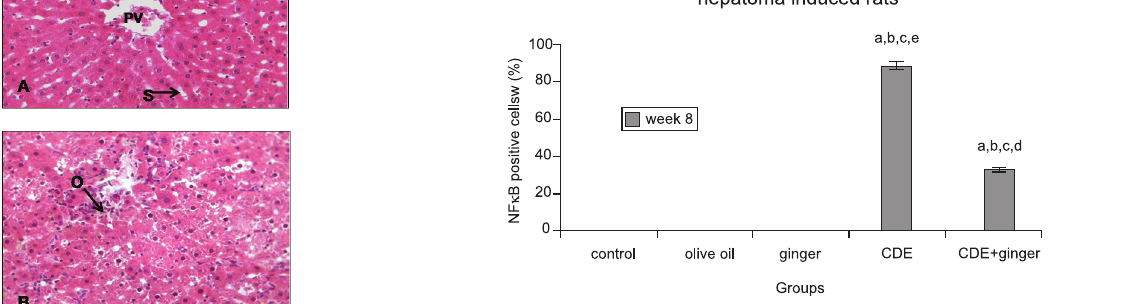
Figure 3 - The effect of ginger extract on NFkB expression in liver cancer- induced rats. The graph shows the positive expression of NFkB based on the different diets given. A = p ≤ 0.05 compared with eight-week control group; b = p ≤ 0.05 compared with olive oil group; c = p ≤ 0.05 compared with ginger group; d = p ≤ 0.05 compared with liver cancer induced group (CDE); e = p ≤ 0.05 compared with CDE+ginger